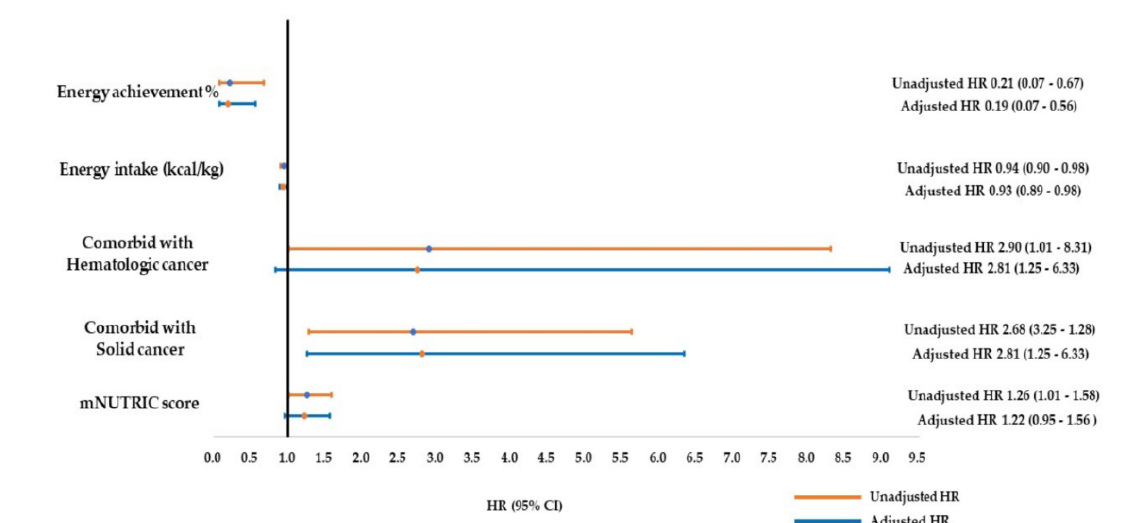
Figure 3. Hazard ratio (HR) of ICU mortality of critically ill patients with high nutritional risk and moderate to severe ARDS receiving prolong prone positioning (PP) therapy. mNUTRIC score: modified nutrition risk in the critically ill